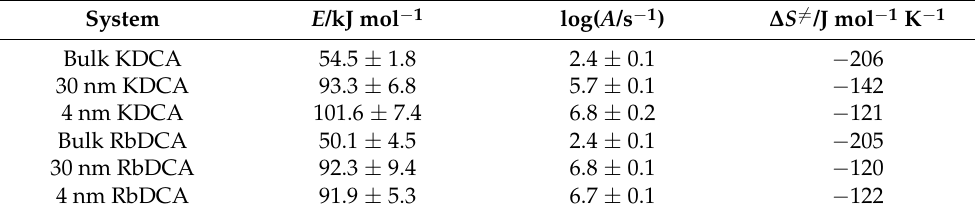
Table 2. Kinetic parameters for trimerization of KDCA and RbDCA in the nanopores and bulk. Reproduced with permission from Yancey and Vyazovkin [44]. Copyright 2015 PCCP Owner Societies.